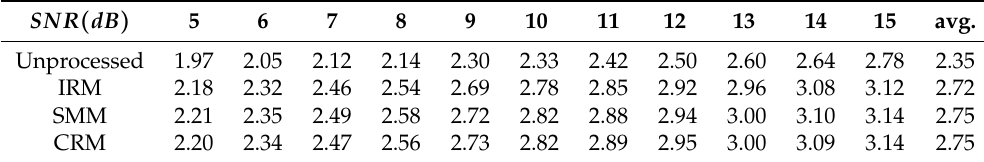
Table 2. Effect of echo attenuation on